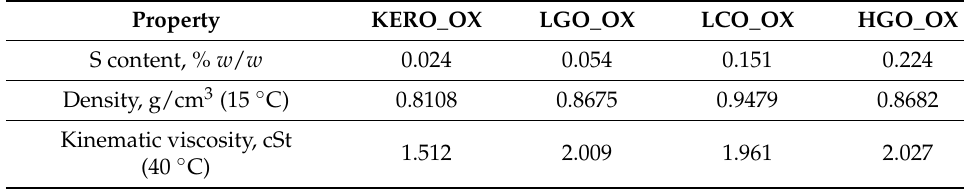
Table 3. Properties of the intermediate oxidized surrogate feeds.